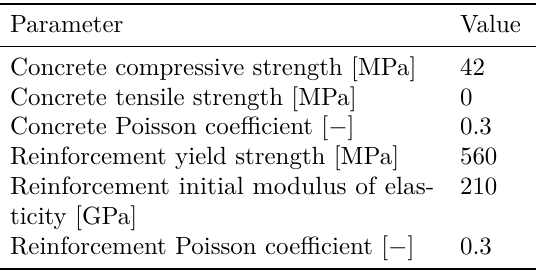
Table 2. Material